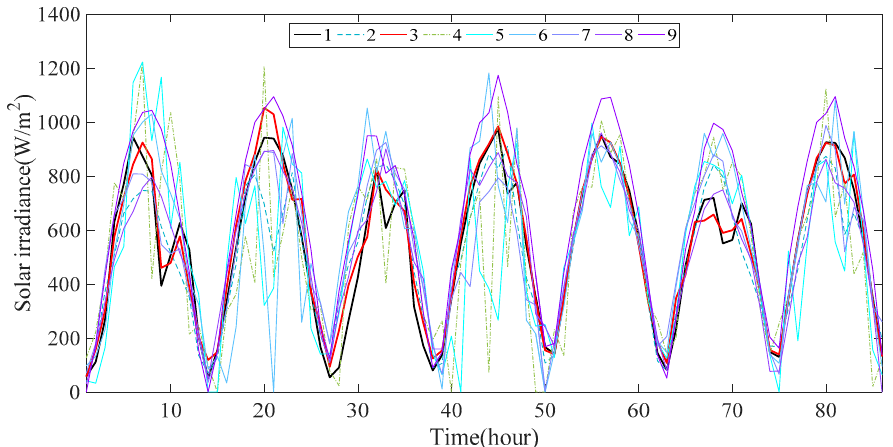
Figure 11. Actual and forecasted solar irradiance at Desert Rock station. Figure legend: 1-Actual data, 2-Forecast results using single fusion model, 3-Forecast results using classified fusion models, 4-Forecast results of 0-level WD model (standard ANN model), 5-Forecast results of 1-level WD model, 6-Forecast results of 2-level WD model, 7-Forecast results of 3-level WD model, 8-Forecast results of 4-level WD model, 9-Forecast results of 5-level WD model.